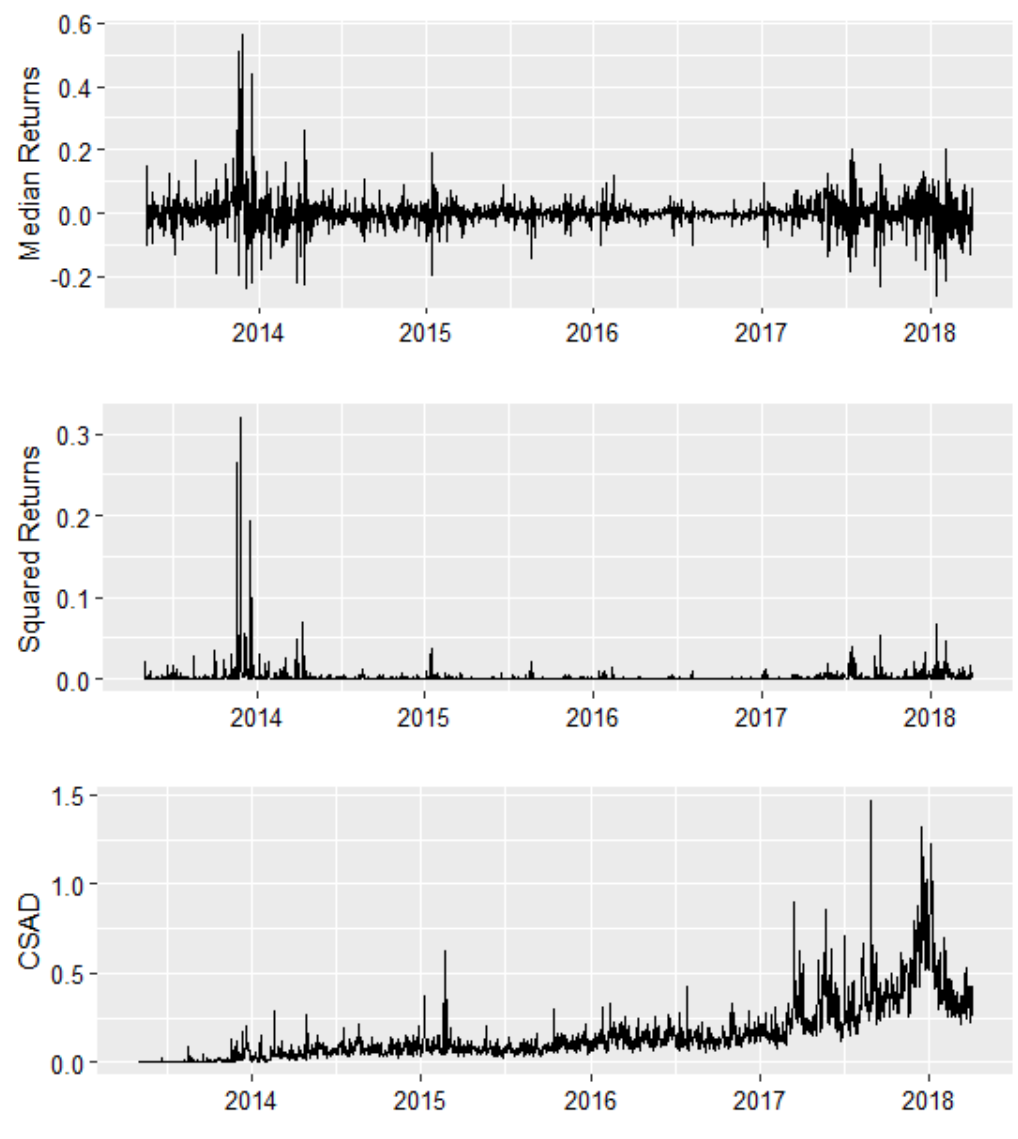
Figure 2: Actual and squared cryptocurrency’ market median returns and